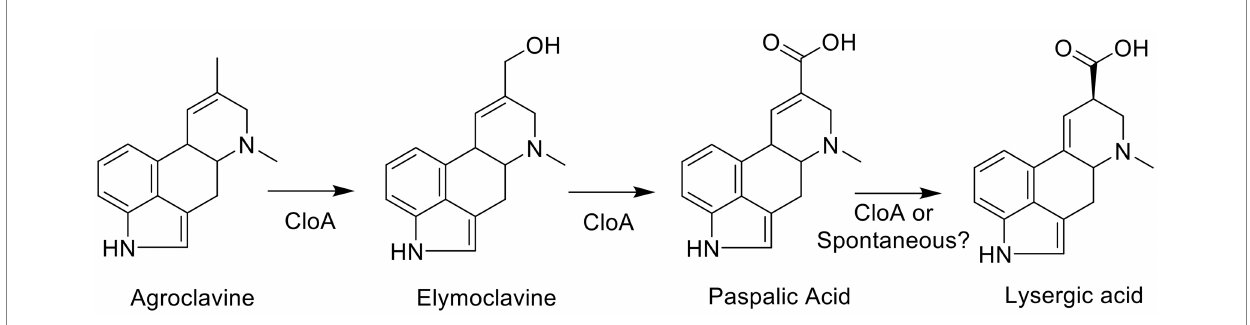
FIGURE 1 Clavine oxidase (CloA) catalyzes multiple oxidation steps of agroclavine to form elymoclavine and thereafter lysergic